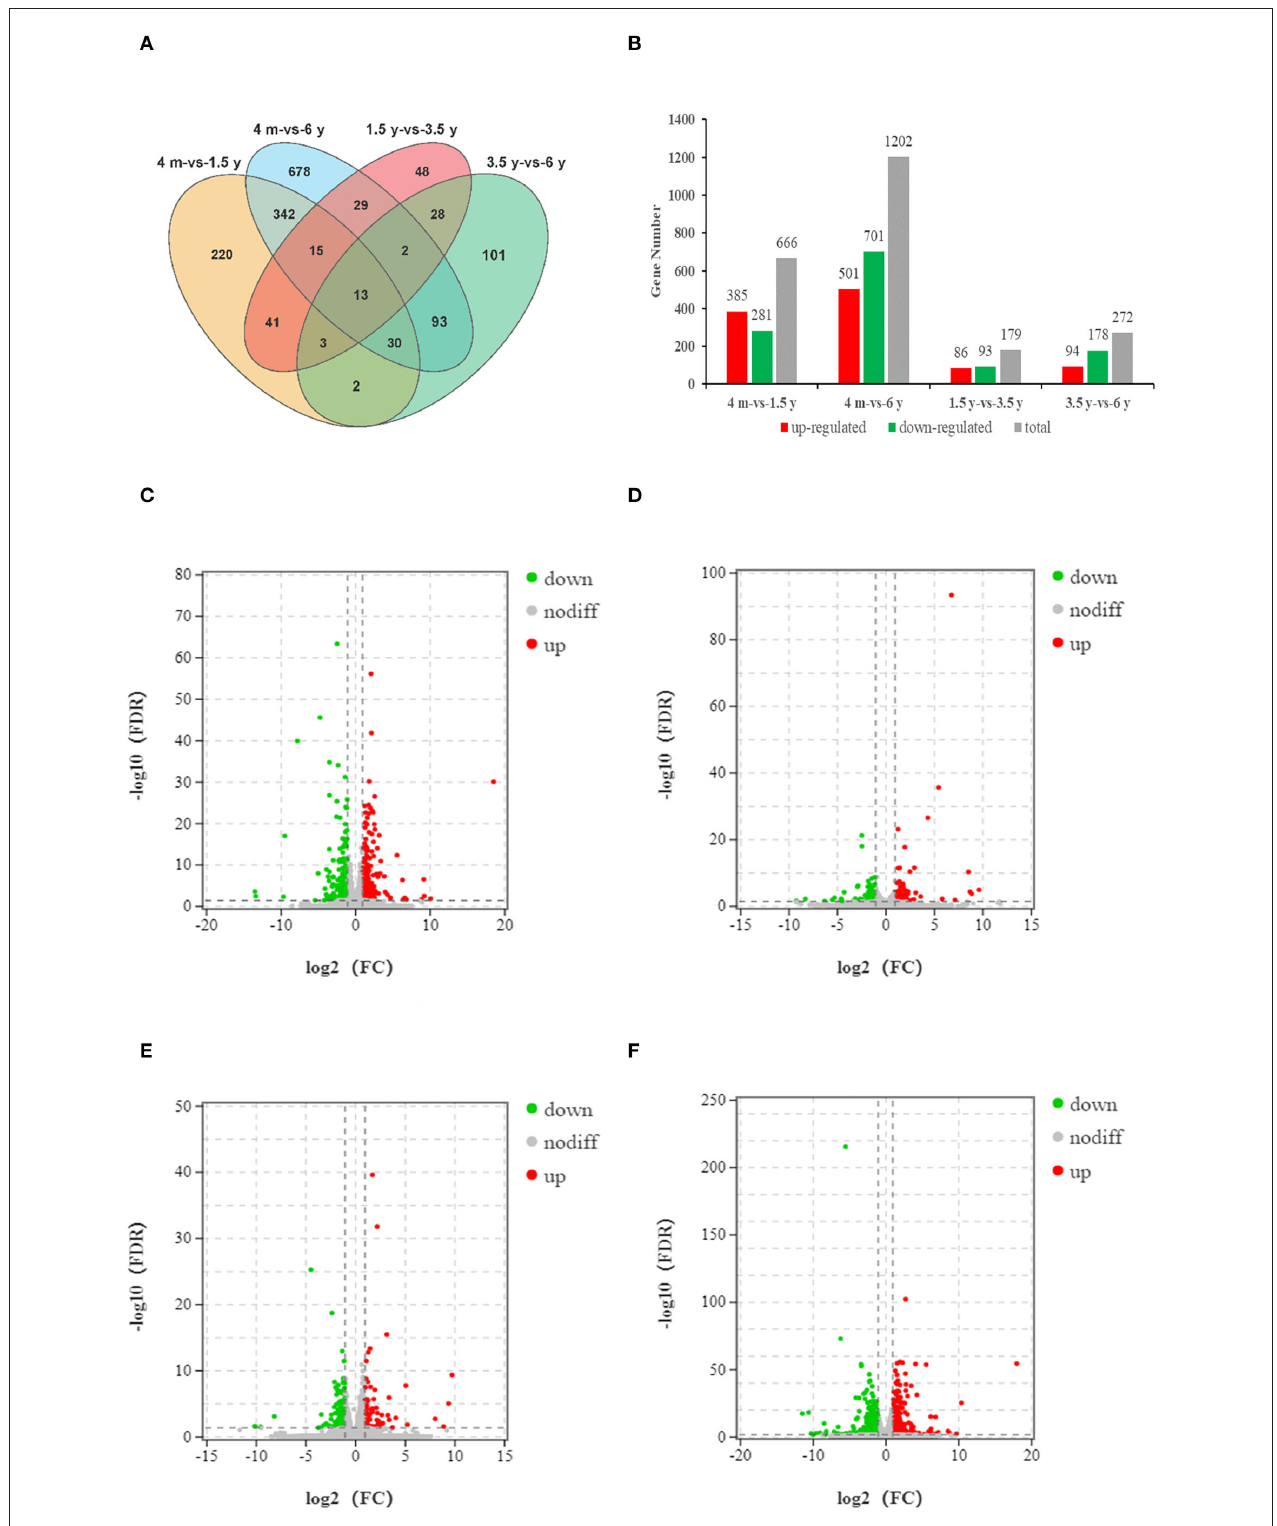
FIGURE 1 | Analysis of the DEGs of four groups. (A) The Venn diagram of DEGs. (B) Histogram of DEGs of four comparative groups. (C–F) Volcano diagrams of DEGs in group of 4 months vs. 1.5 years, 1.5 years vs. 3.5 years, 3.5 years vs. 6 years, and 4 months vs. 6 years, respectively. The abscissa represents the logarithm of the fold change of DEGs between the two groups, and the ordinate represents the negative log 10 value of the FDR of the DEGs between the two groups. A point in the volcano represents a gene, red represents up-regulated genes, green represents down-regulated genes, and black represents non-differentially expressed genes.